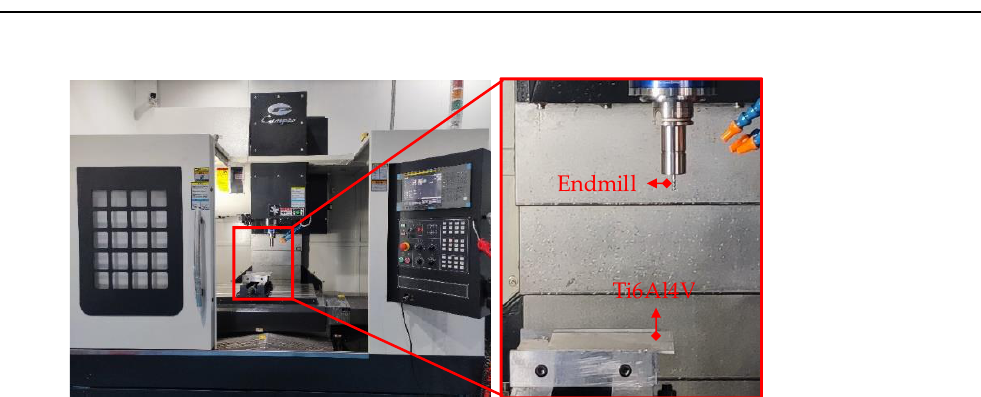
Figure 4. Milling experiment.